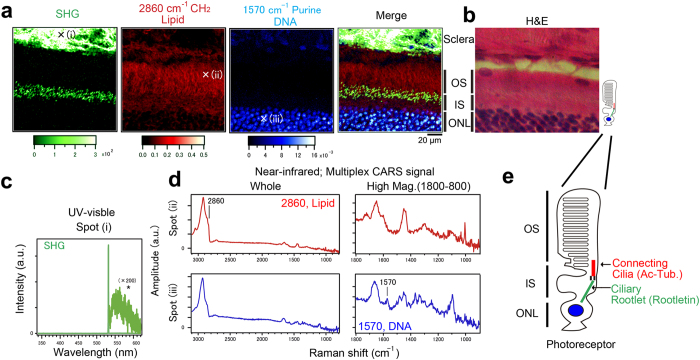
Truly label-free penta-modal CNOM visualizes hierarchical structures of retinal layers, highlighting novel SHG-indicated filamentous layers.Spectroscopic imaging was performed with fixed rat retina using our custom microscope. (a) A collection of label-free images of SHG (green) and CARS at 2860 cm−1 (red) and 1570 cm−1 (blue), showing the distributions of harmonophores, lipid, and DNA, respectively. Note the unexpected filamentous layer in the middle of the SHG image. (b) Representative image of retinal layers by H&E staining with the indicated anatomies. OS, IS, and ONL correspond to outer segment, inner segment, and outer nuclear layer, respectively. (c) Representative spectra of SHG for image reconstruction (spot (i) in (a)). (d) Representative retrieved spectra of CARS at the positions of (ii) and (iii) in (a). Right, higher magnification of left at 1800–800 cm−1. Because raw CARS spectra were distorted due to interference between vibrationally resonant and non-resonant coherent signals, we used the maximum entropy method (MEM) to retrieve the raw CARS spectra to Im[χ(3)] spectra corresponding to the conventional spontaneous Raman scattering spectrum. (e) Schematic of a photoreceptor highlighting the internal filamentous structures connecting cilia and ciliary rootlets. Parentheses indicate marker antibodies. Bar, 20 μm. Color scales indicate intensity (a.u.) or amplitude (a.u.).